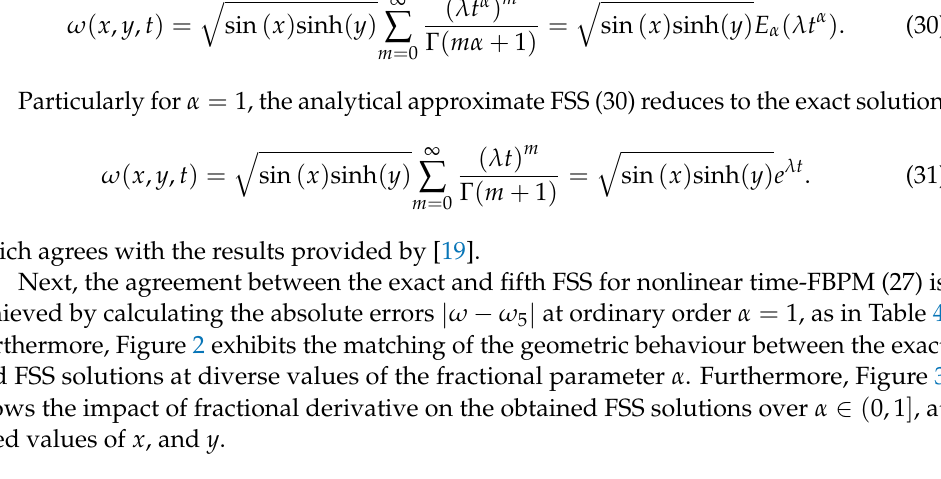
Table 4. Numerical results for the non-linear time-FBPM (27) when α = 1 . ω ω 5 | ω − ω 5